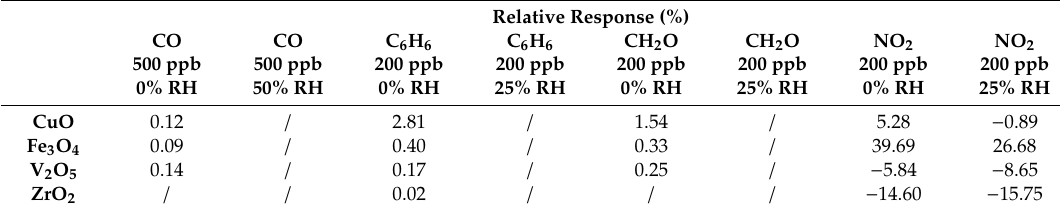
Table 1. Summary of relative responses towards CO, C 6 H 6 , CH 2 O, and NO 2 in dry and humid conditions.